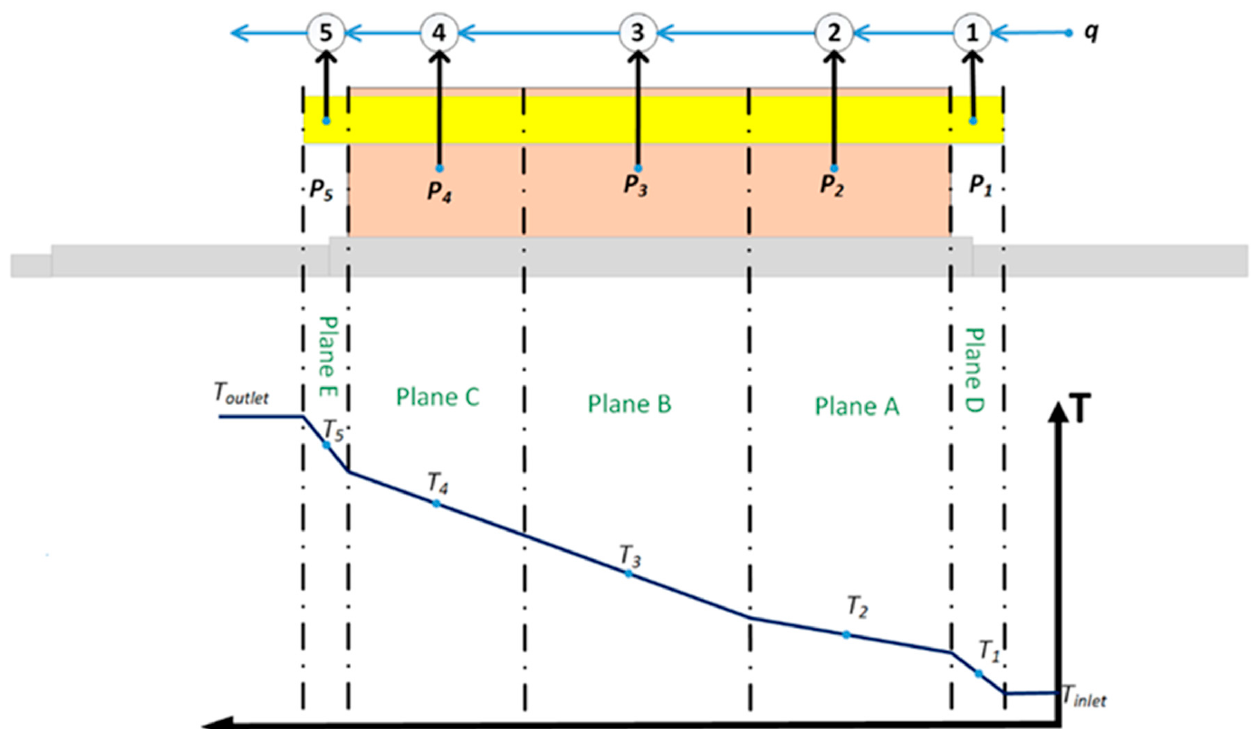
Figure 6. Rotor’s coolant network and its temperature rising diagram.